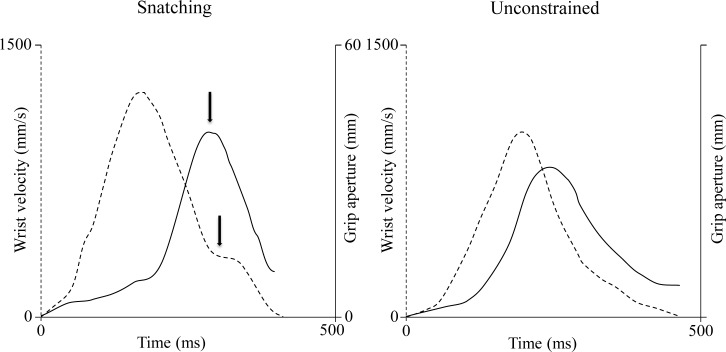
Superimposition of the velocity and grip profiles for the snatching and the unconstrained conditions.Arrows indicate the correspondence between the time at which the maximum grip aperture and the beginning of the low velocity phase occur for an individual movement for the snatching condition. Dashed lines = velocity profiles. Solid Lines = grip profiles.